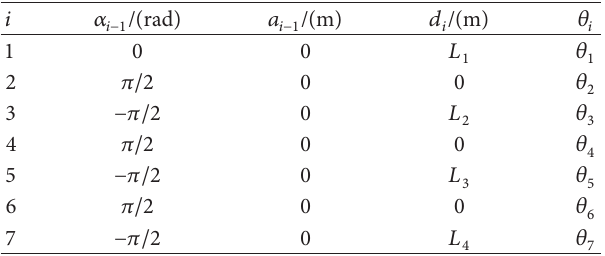
Table1:D-Hcoordinatedesignparametersoftheanthropomorphic